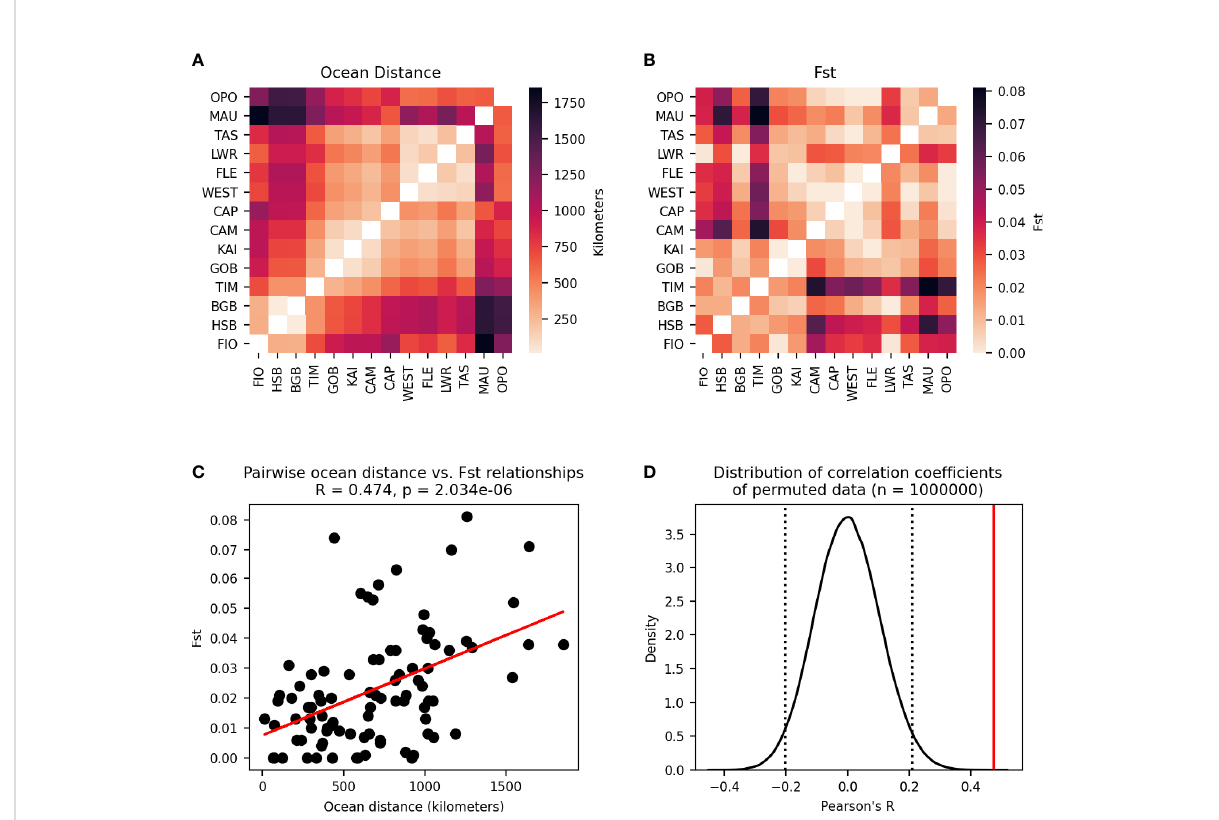
FIGURE 11 Modi fi ed Mantel test between pairwise ocean distances between populations and pairwise F ST. (A) Pairwie ocean distance matrix. (B) Pairwise F ST matrix. (C) Pairwise relationships between cells in the two matrices are plotted as points with a line showing the best fi t of the data. Pearson ’ s correlation coef fi cient and p-value of the correlation are given. (D) Distribution of correlation coef fi cients between the ocean distance matrix and 1,000,000 permutations of the F ST matrix. Dotted lines enclose 95% of the distribution, and the solid line shows the correlation coef fi cient of the unpermuted